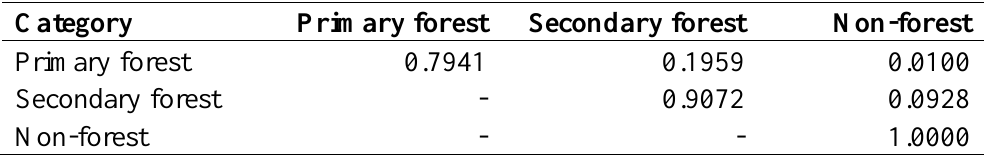
Table 4. Forest conversion probability matrix for 1993–2000.